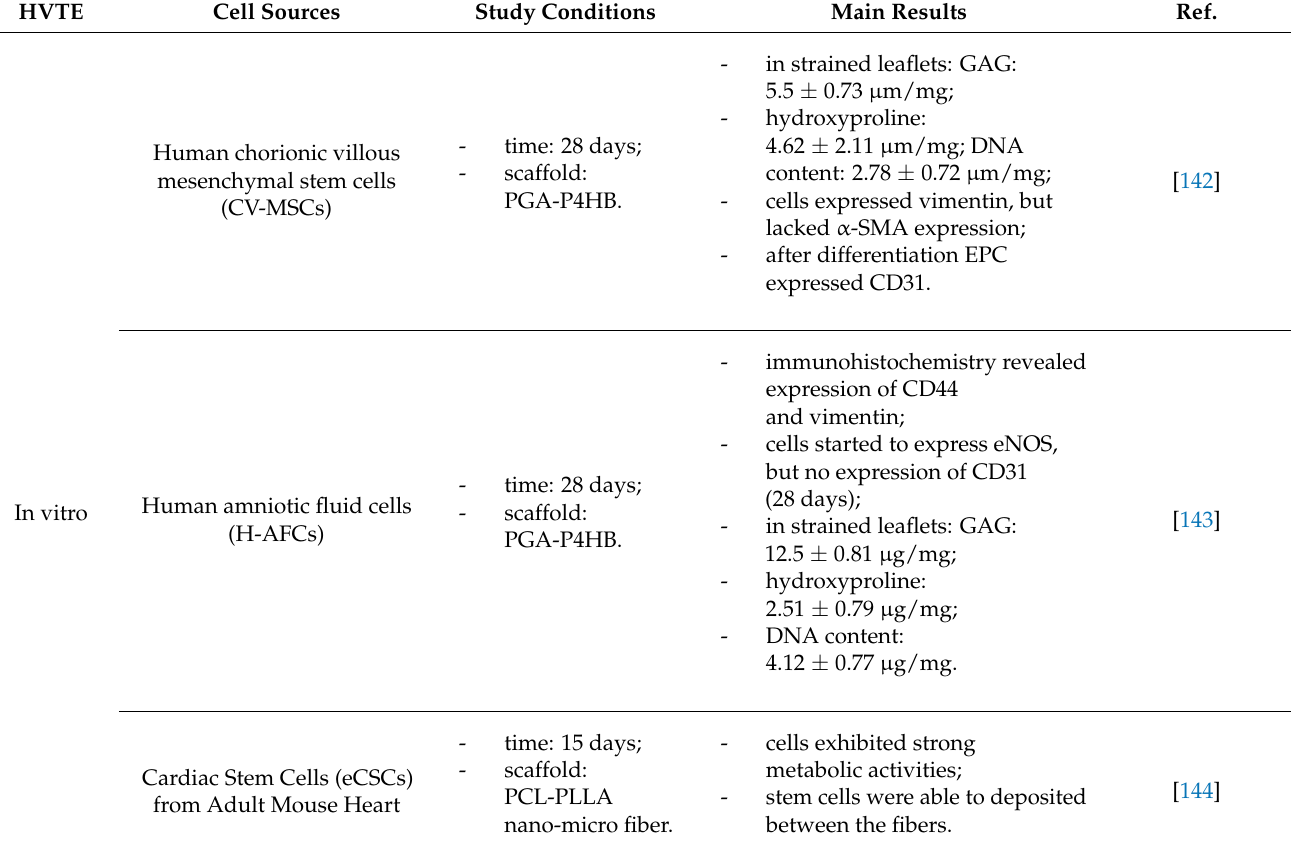
Table 4. Overview of cell sources and scaffold materials used for pulmonary valve